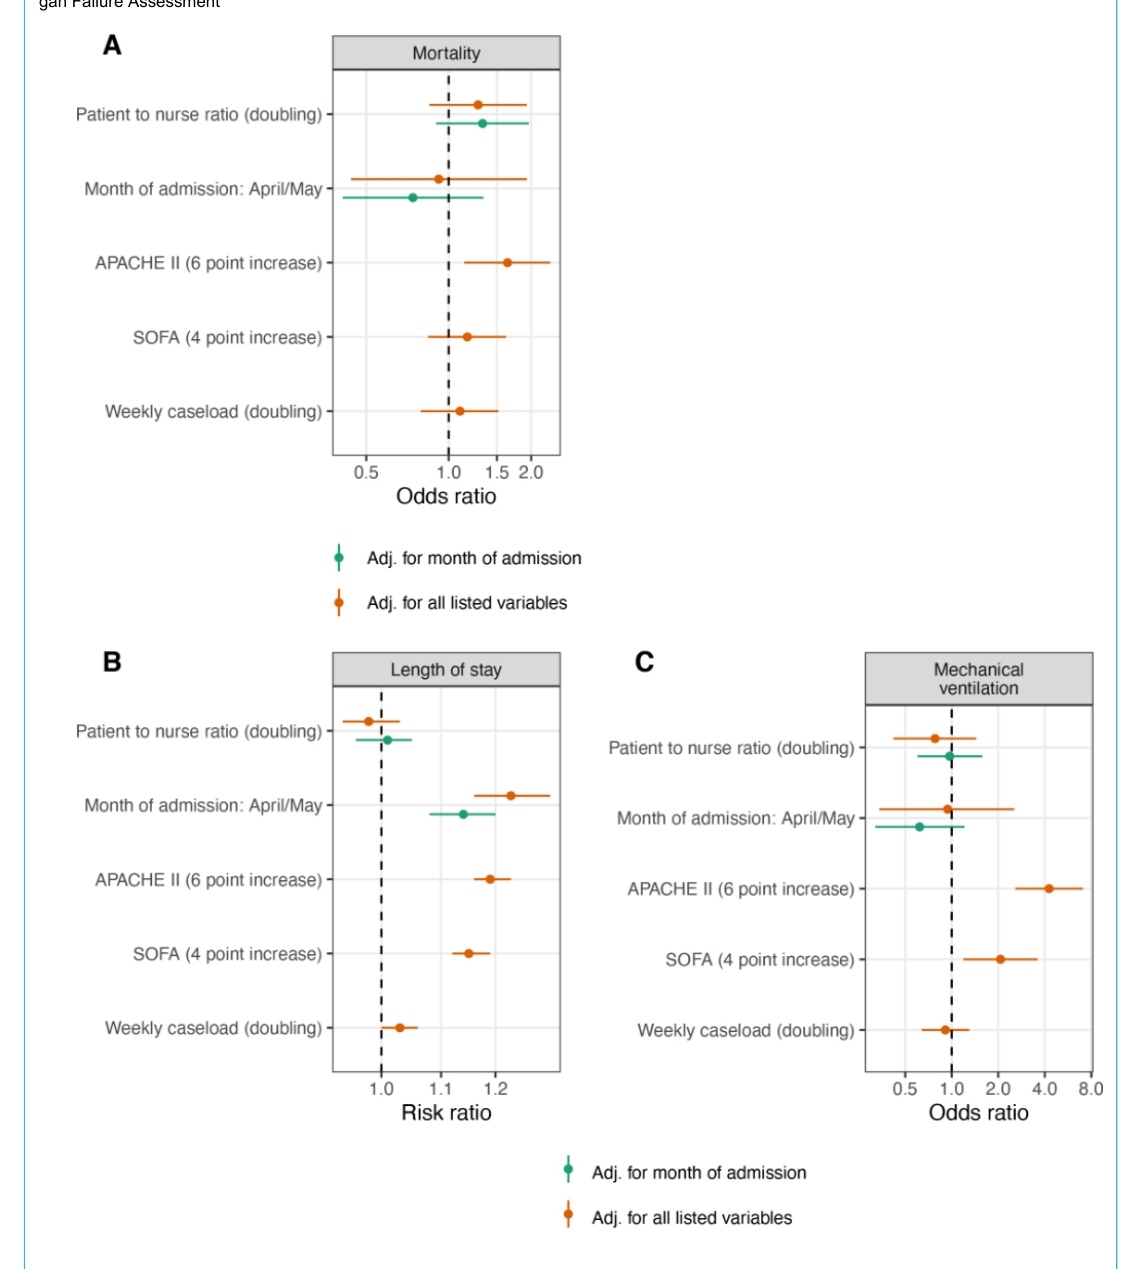
Figure 3: Patient-to-nurse ratio and study outcomes. APACHE II = Acute Physiology and Chronic Health Evaluation II, SOFA = Sequential Or- gan Failure